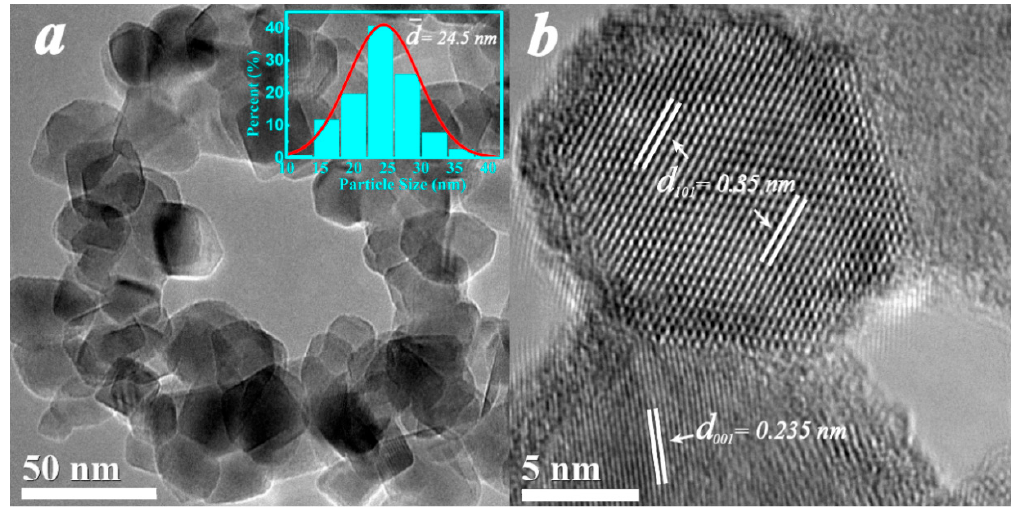
Figure 2. ( a ) TEM image of Ag@TiO 2 (0.06 wt %, 30 min radiation) and NPs size distribution graphic (obtained by counting 114 Ag@TiO 2 particles); ( b ) HRTEM images of the prepared Ag@TiO 2 composites, d 001 = 0.235 nm, d 101 = 0.35 nm. Table 1. ICP-AES date of Ag@TiO 2 .